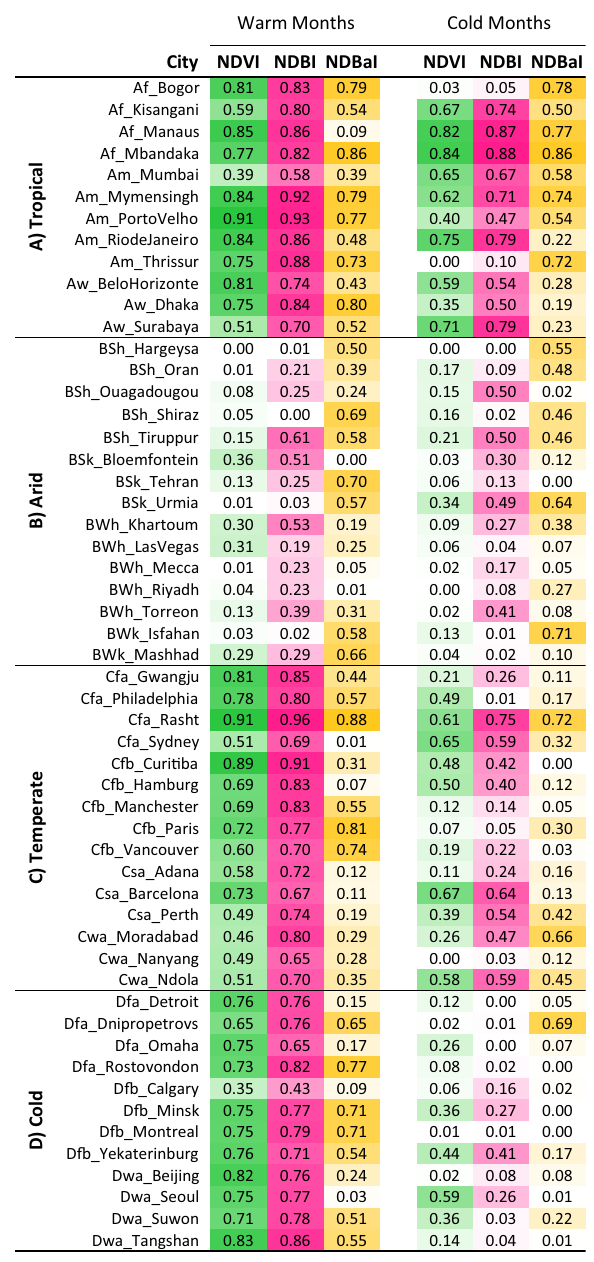
Figure 5. The estimated coefficients of determination (R 2 ) between land cover variables (NDVI, NDBI, NDBaI) and LST for 54 selected cities during warm and cold months. The colour gradient is for ease of comparison of R 2 values. Darker colours represent stronger relationships, while lighter colours indicate weaker